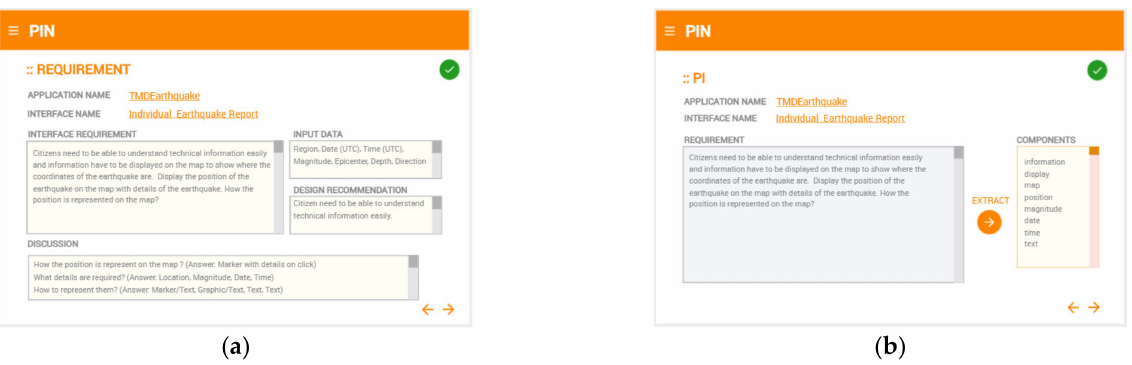
Figure 9. ( a ) A mockup screen for automatic analysis of the requirements. ( b ) A mockup screen of automatic identification of UI